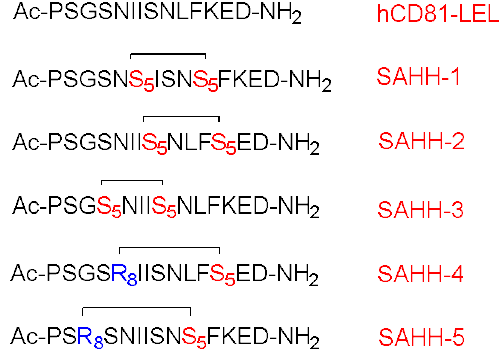
Figure 7. The sequences of the parent hCD81-LEL peptide and five analogs with different stapling positions. Fmoc-S 5 -OH and Fmoc-R 8 -OH are shown at the right in red and blue, respectively. The parent peptide was identified and synthesized by Dhanasekaran et al. [62]. For S 5 and R 8 , refer to the legend of Figure 6.